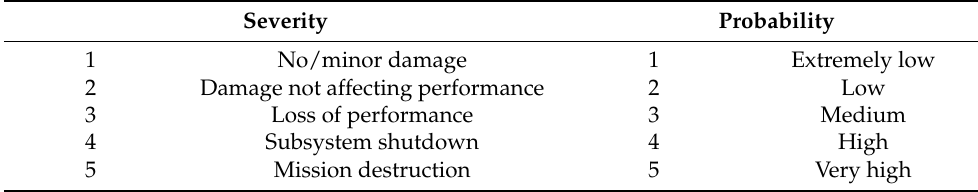
Table 1. The severity and probability weights used for the risk assessments.